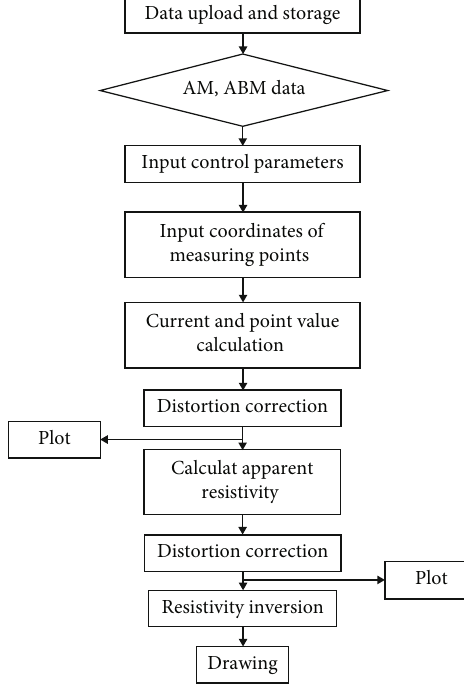
Figure 5: Data processing fl